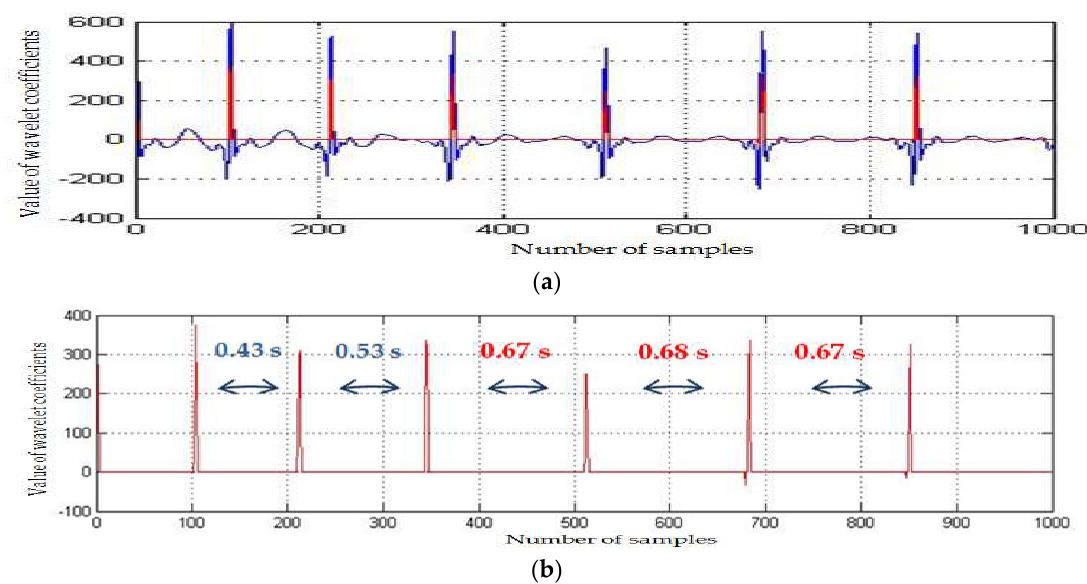
Figure 7. ( a ) Zoom on bradycardia event for infant1_ecgm , db8 MW, 1000 samples (minute 32–33 of recording). ( b ) Zoom on